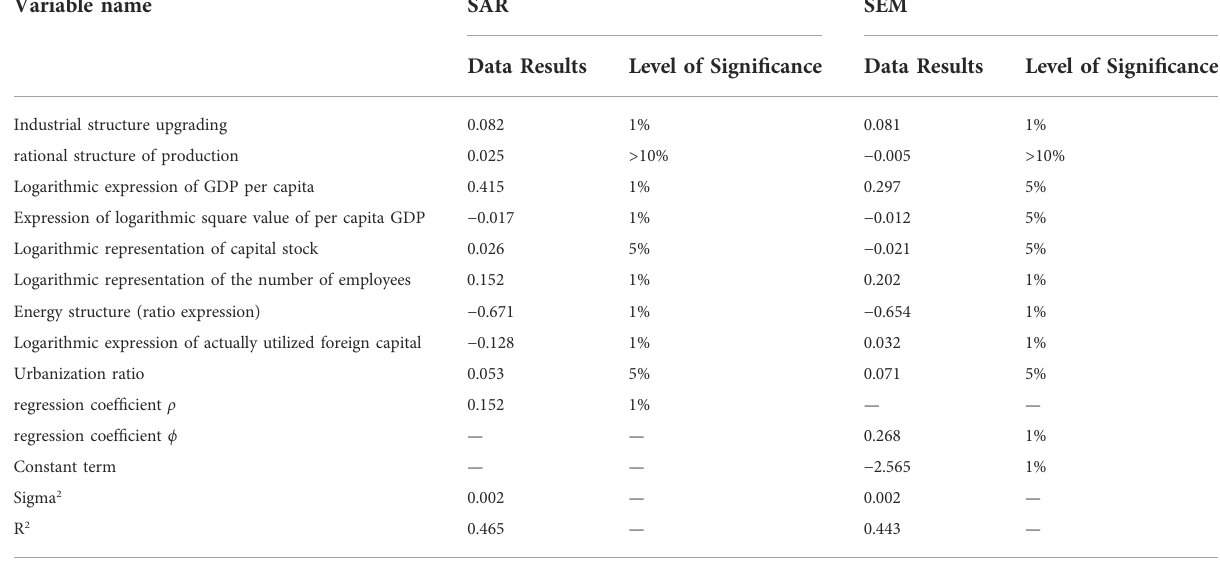
TABLE 4 Robustness test results under geographical